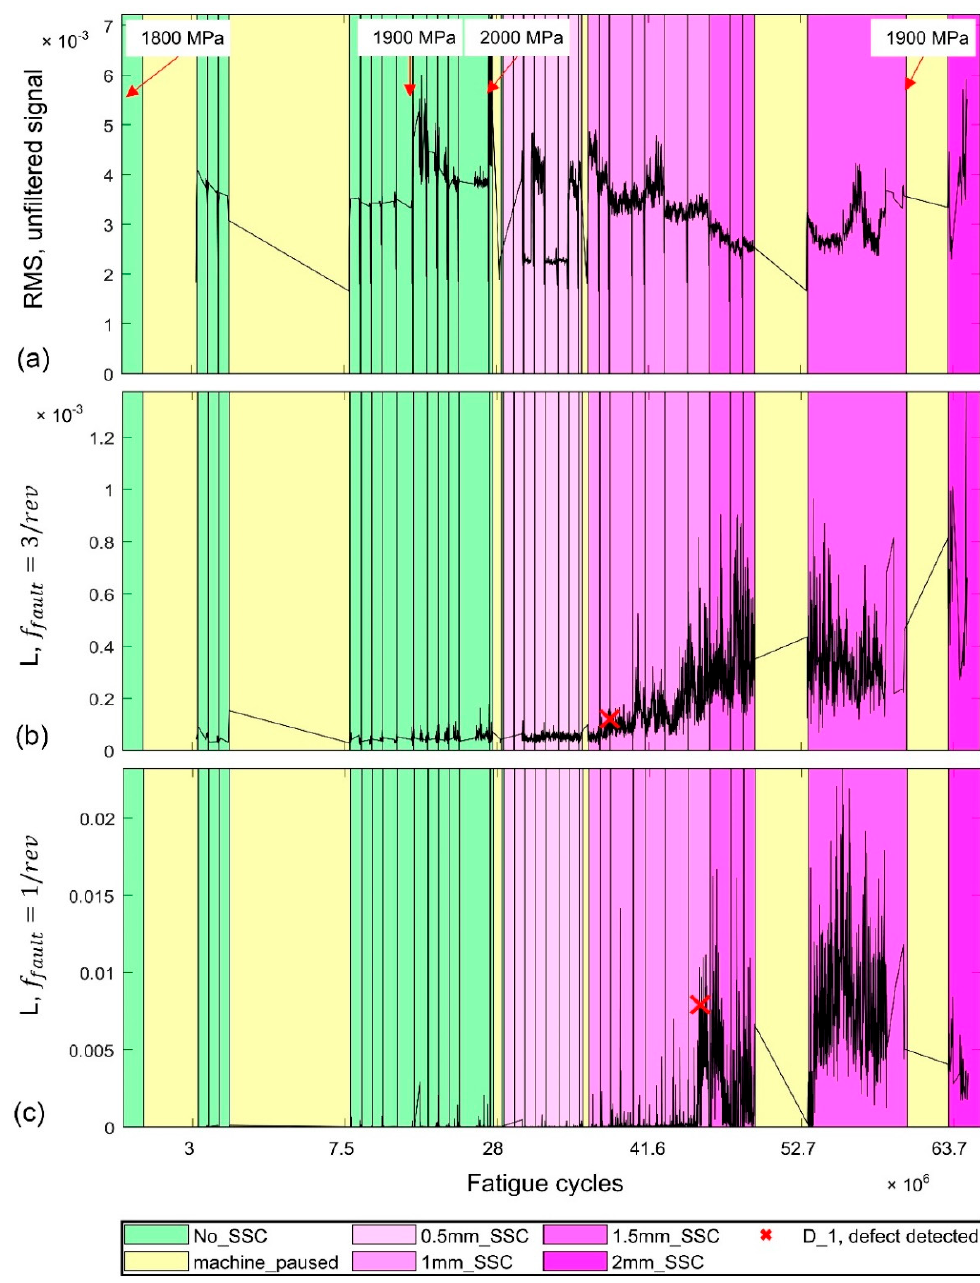
Figure 7. The AE behaviour during the durability test: ( a ) the conventional AE rms value as a function of the number of fatigue cycles; the likelihood ratio, L , corresponding to two fault frequencies ( b ) f fault = 3/ rev and ( c ) f fault = 1/ rev , respectively. The points corresponding to changes in contact pressure are indicated in ( a ). The test status is colour coded, as shown in the legend. The black vertical lines indicate the moments of PAUT inspections. The break points highlighting decisions, D 1, are marked by red crosses in ( b , c ).